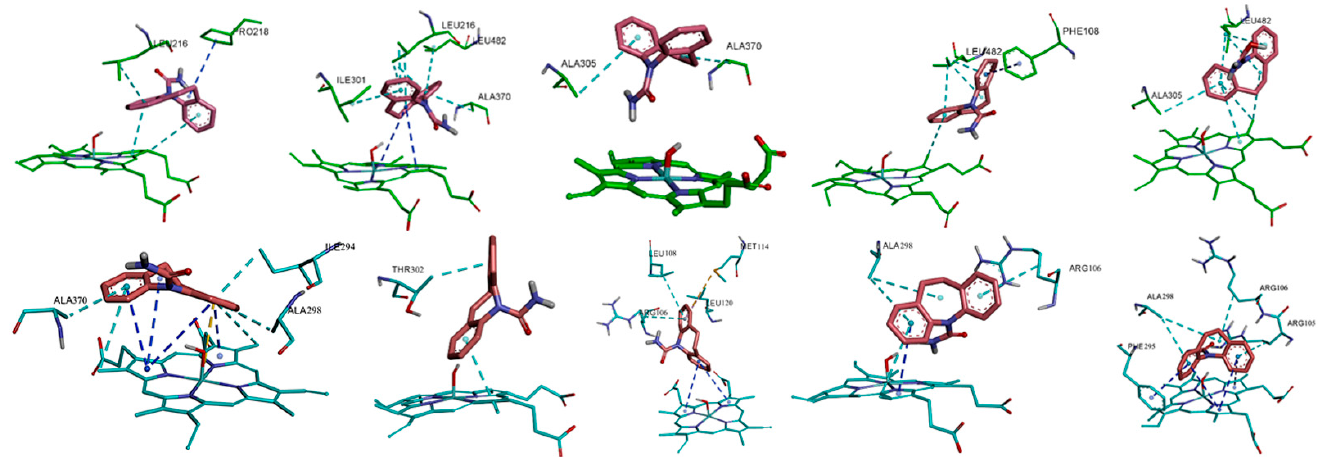
Figure 5. The hydrophobic interaction (dotted line colored in cyan) and π - π interaction (dotted line colored in dark blue) between the substrate CBZ and the surrounding residue in the CYP3A4-CBZ ( upper ) and CYP3A5-CBZ ( lower ) complex systems.